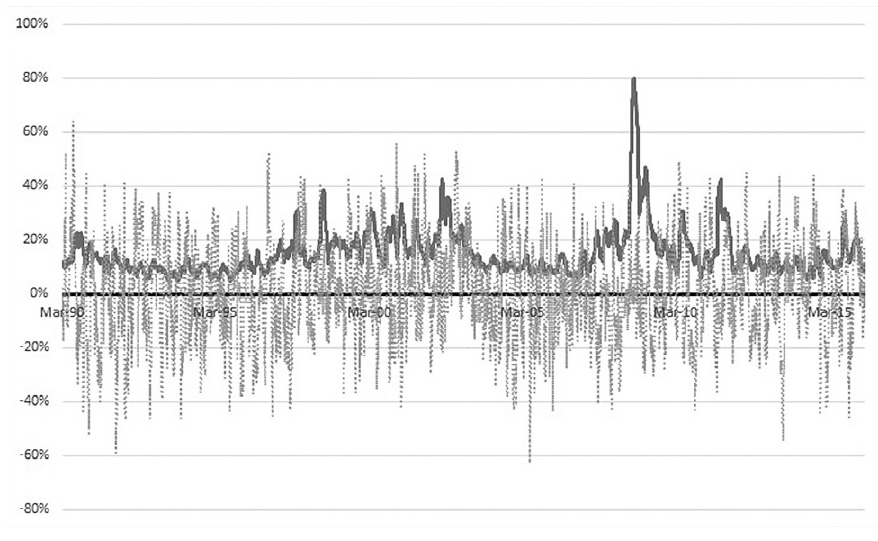
Figure 9. Volatility structure of S&P 500 and 3-month Treasury Bill rate Note: Volatility of the S&P 500 (solid gray line), volatility of the 3-month Treasury Bill rate (solid black line), and their rolling correlation (dotted gray line).